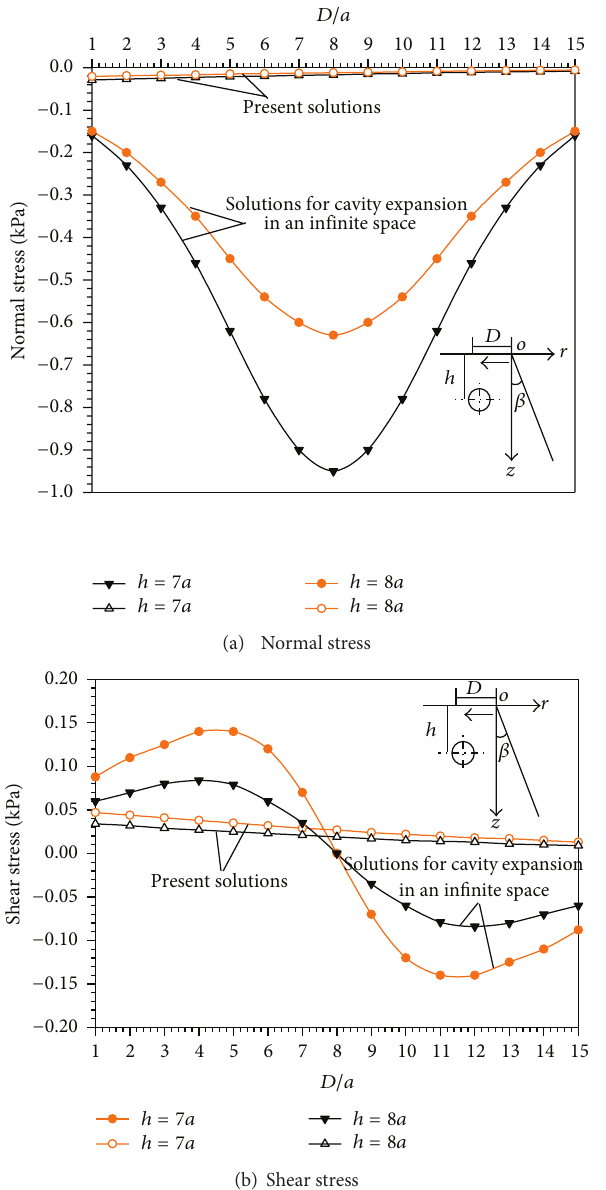
Figure 8: Stress along the horizontal free surface.